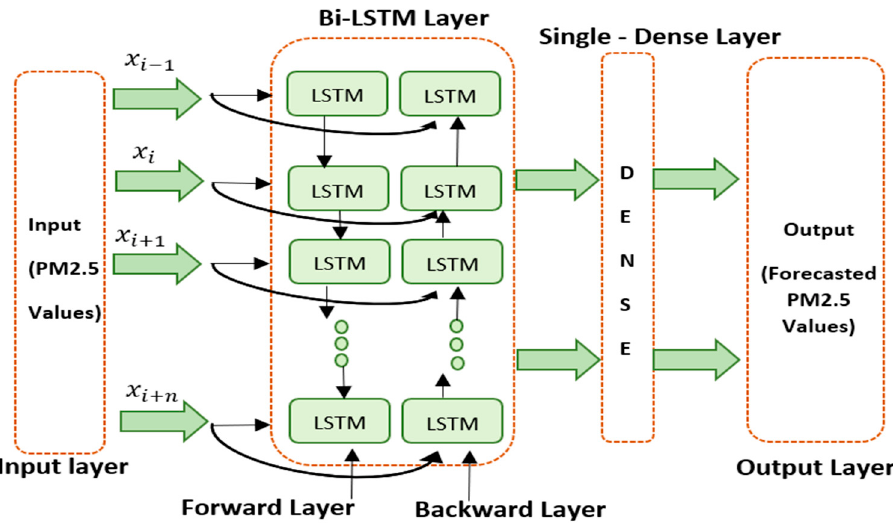
Figure 5. A Single-Dense Layer BiLSTM architecture.